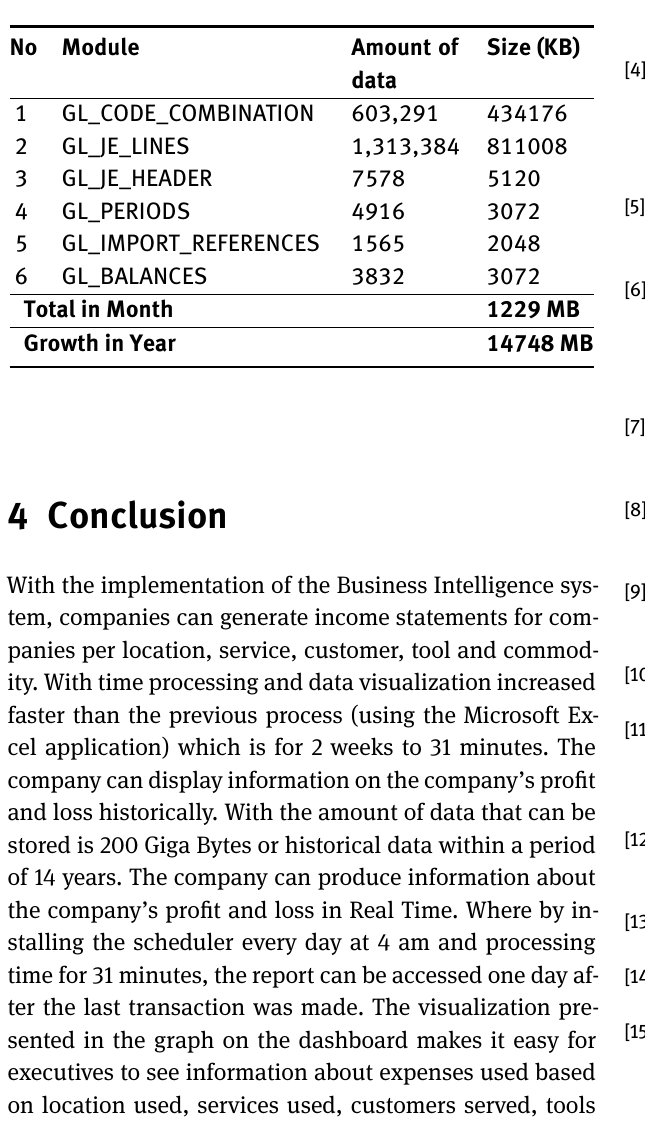
Table 4: Evaluate disk space